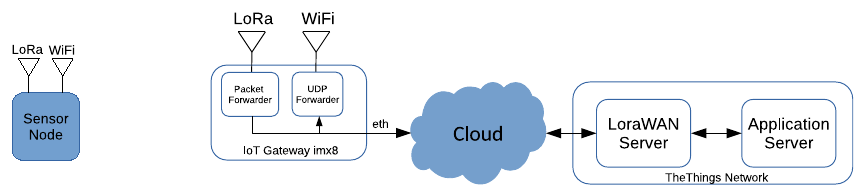
Figure 7. The IoT gateway with the server implemented on the cloud.